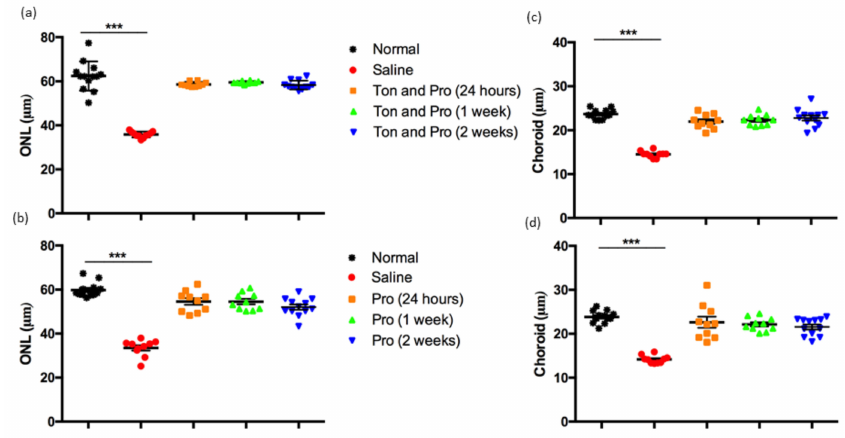
Figure 3. Effect of saline, probenecid with tonabersat and probenecid treatments on the light- damaged rat retinal and choroidal thickness. The ONL thickness was obtained from OCT images of tonabersat and probenecid treated rats ( a ), and the probenecid treated group ( b ). The choroidal thickness was measured by OCT analysis in the tonabersat and probenecid group ( c ) and probenecid group ( d ). Data are expressed as mean ± SEM. Abbreviations: Ton, tonabersat; Pro, probenecid; ONL, outer nuclear layer. Statistical analysis was conducted using one-way ANOVA, followed by a post-hoc test. Significant values are indicated with asterisks: *** p <